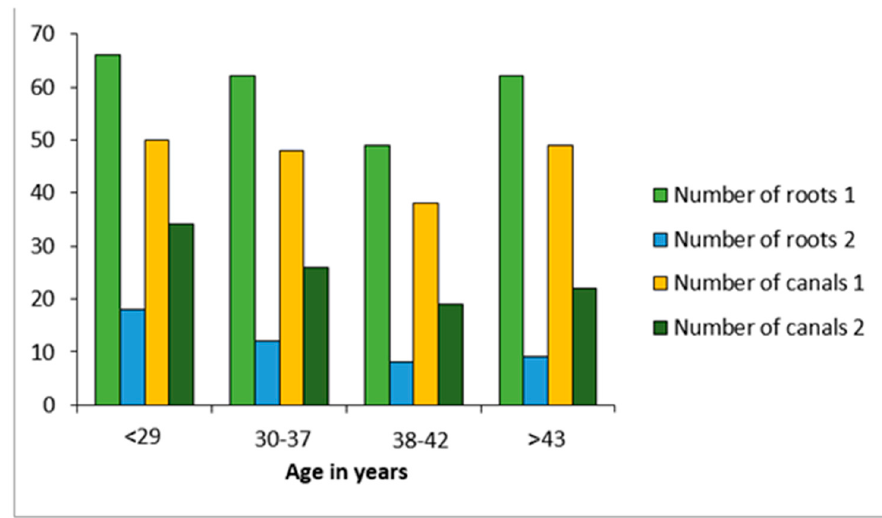
Figure 4. Number of roots and canals in relation to age.